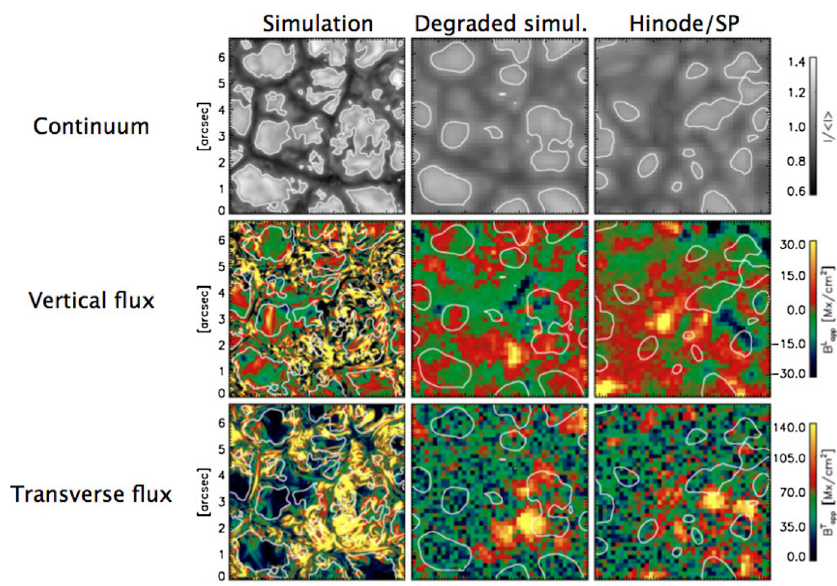
Fig. 40 Comparison of the vertical and transverse field components generated by a surface dynamo simu- lation (left) with Hinode/SP observations (right), after calculation of synthetic Fe i 630 nm Stokes profiles and suitable degradation to match the specifications of the Hinode SP (middle). Image reproduced with permission from Danilovic et al. (2010b), copyright by